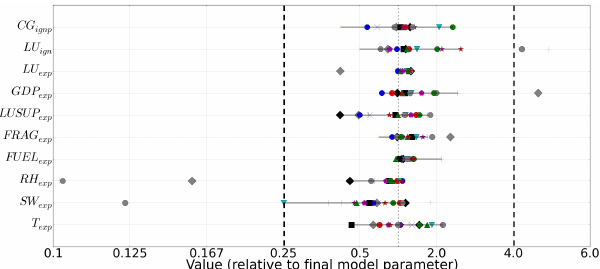
Figure 4. Parameter variability across the set of optimization runs with different grid cells and years. Among the 20 runs, 16 reached a relatively consistent parameterization (see text). These are rep- resented as colored markers and their range is shown by the black lines. For the other four runs, parameters are shown as grey markers. The vertical dashed lines indicate the lower and upper (symmetric) thresholds of parameters range which were used to separate these four